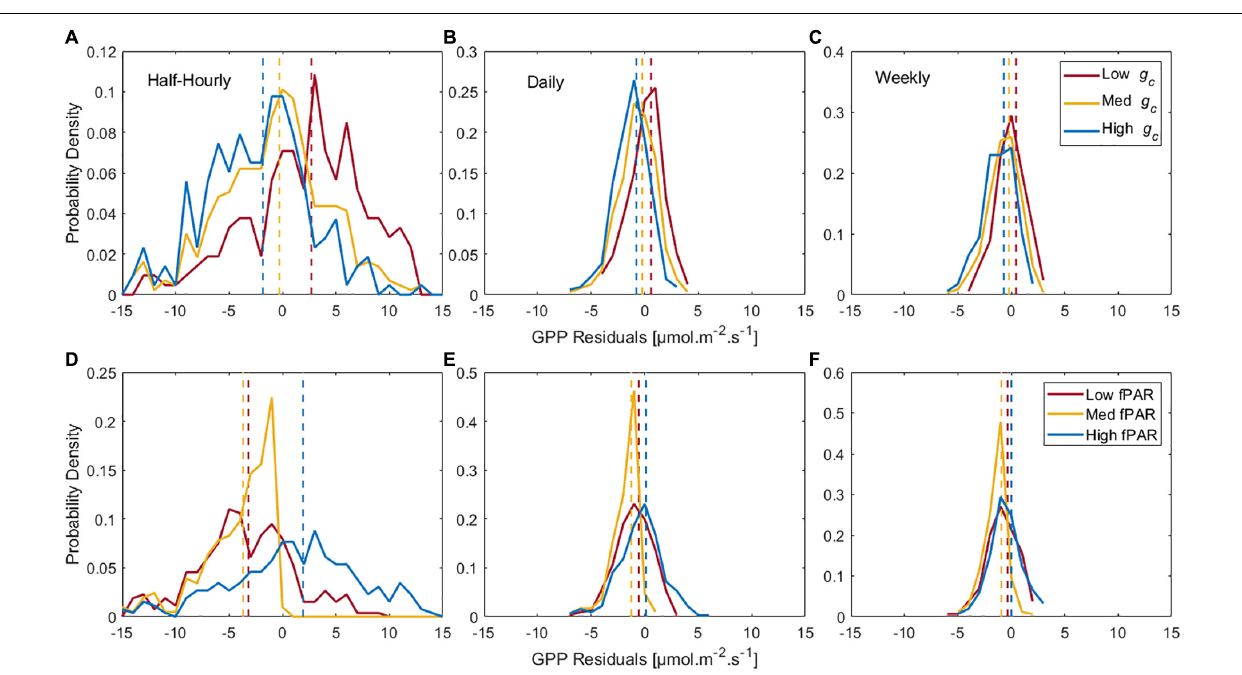
FIGURE 5 | Probability density function of the LME model residuals (observation-model) for GPP as a function of SIF (fixed effect) and site (random effect) under low, intermediate, and high canopy conductance (0–33th percentile, 33th–67th, and 67th–100th percentiles of g c values within each site, respectively) at (A) Half-hourly, (B) Daily, and (C) Weekly timescales. Distribution density function of the residuals (observation-model) of the same model under low, intermediate, and high fPAR (0–33th percentile, 33th–67th, and 67th–100th percentiles of fPAR values within each site, respectively) at (D) Half-hourly, (E) Daily, and (F) Weekly timescales. Dashed lines at the same color represent the mean of each